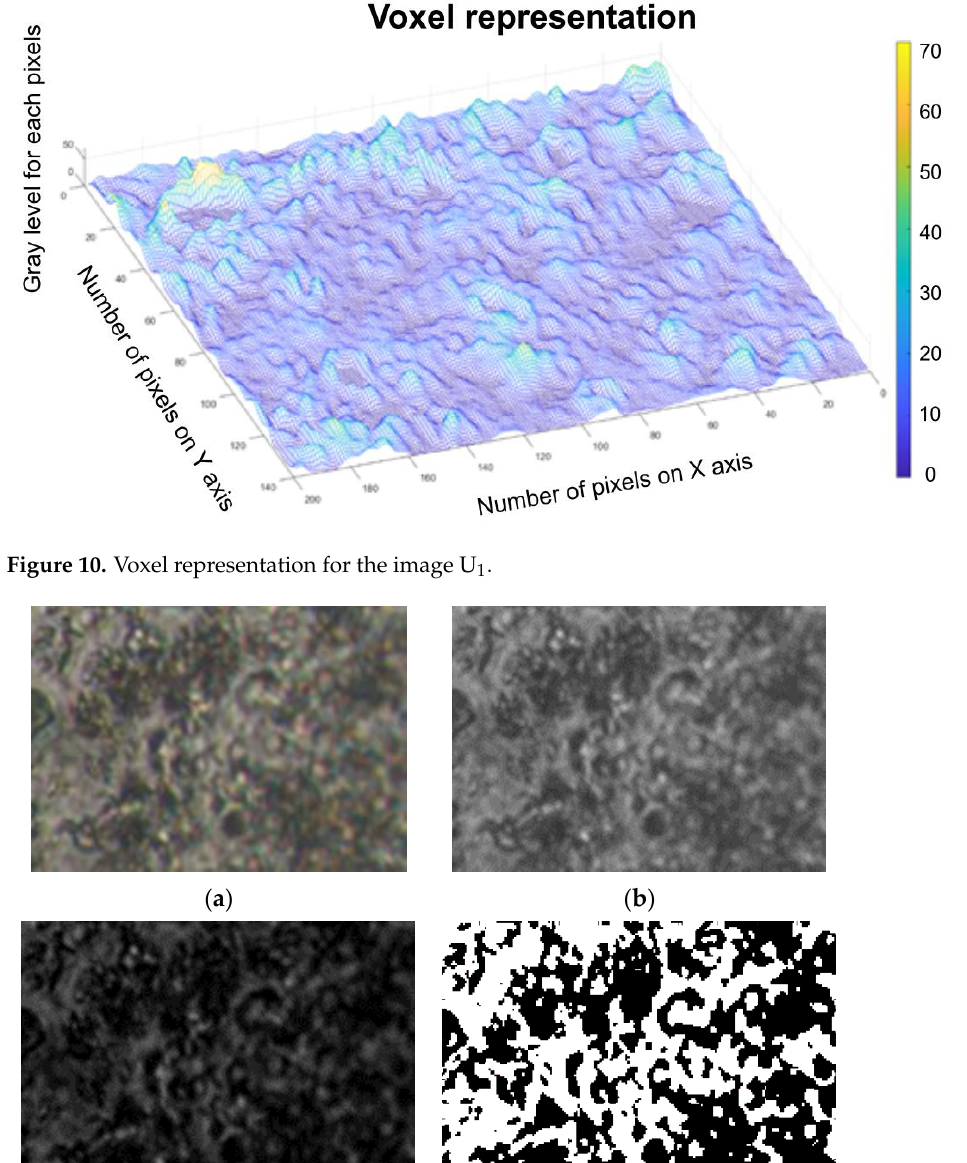
Figure 9. Graphic of fractal dimension for selected U 1 image area.